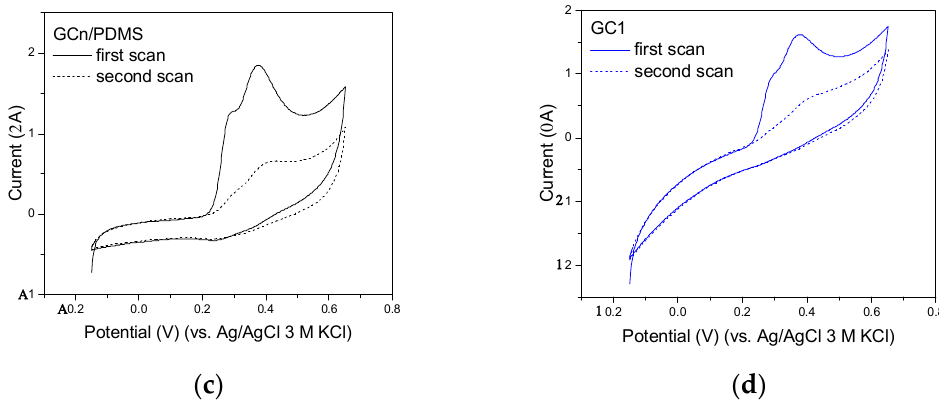
Figure 7. ( a ) Cyclic voltammograms recorded in 5 µM solution of epigallocatechin using paste (GC n /PDMS, graphite/paraffin, GC n /PDMS modified by Y 2 O 3 , Yb 2 O 3 ) and glassy carbon disk (2 mm in diameter, two batches: GC 1 and GC 2) electrodes. ( b ) The area of peaks P 1 and P 2 shown in Figure 7a. ( c , d ) Two subsequent cyclic voltammograms recorded in 5 µM solution of epigallocatechin gallate using ( c ) GC n /PDMS and ( d ) GC 1 electrodes. Supporting electrolyte: 0.1 M acetate buffer, pH = 4.5. Scan rate 50 mV/s.